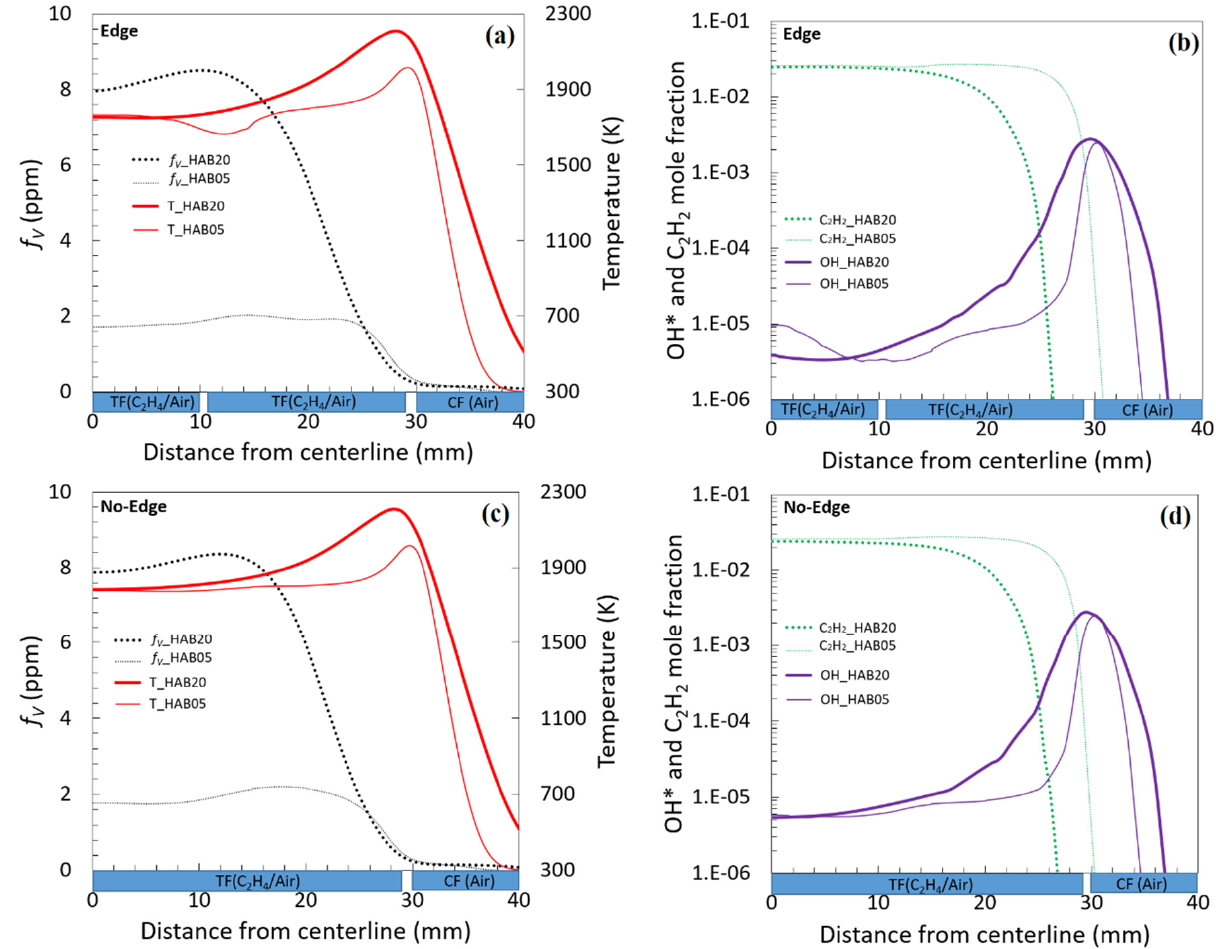
Figure 12. Predicted radial temperature in K (red solid lines), f V in ppm (black dotted lines), and mole fraction of OH radical (violet solid lines) and C 2 H 2 (green dotted lines) as a function of HAB (mm) of the atmospheric target flame C 2 H 4 /air ϕ = 2.1 of matrix diameter 56 mm with ( a , b ) and without EIM ( c , d ) at HAB 5 (thin lines) and 20 (thick lines) mm.